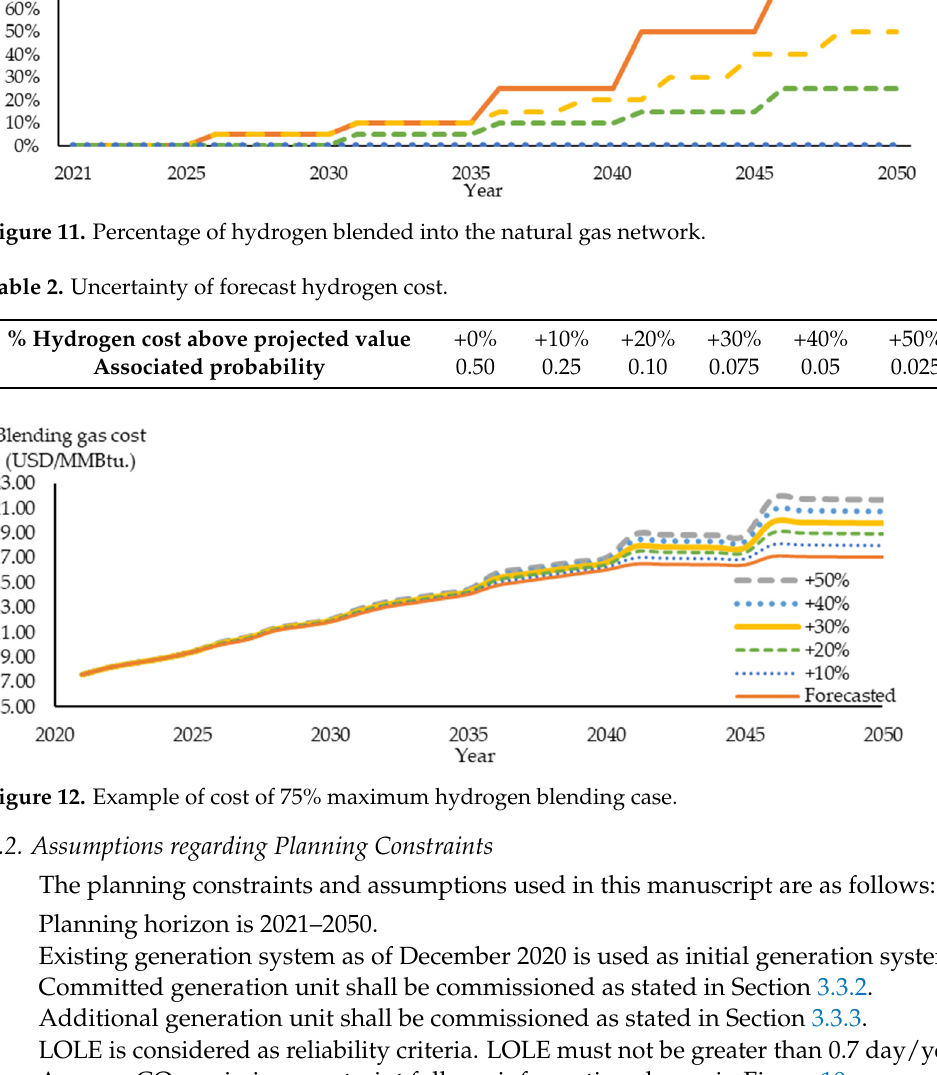
Figure 12. Example of cost of 75% maximum hydrogen blending case.